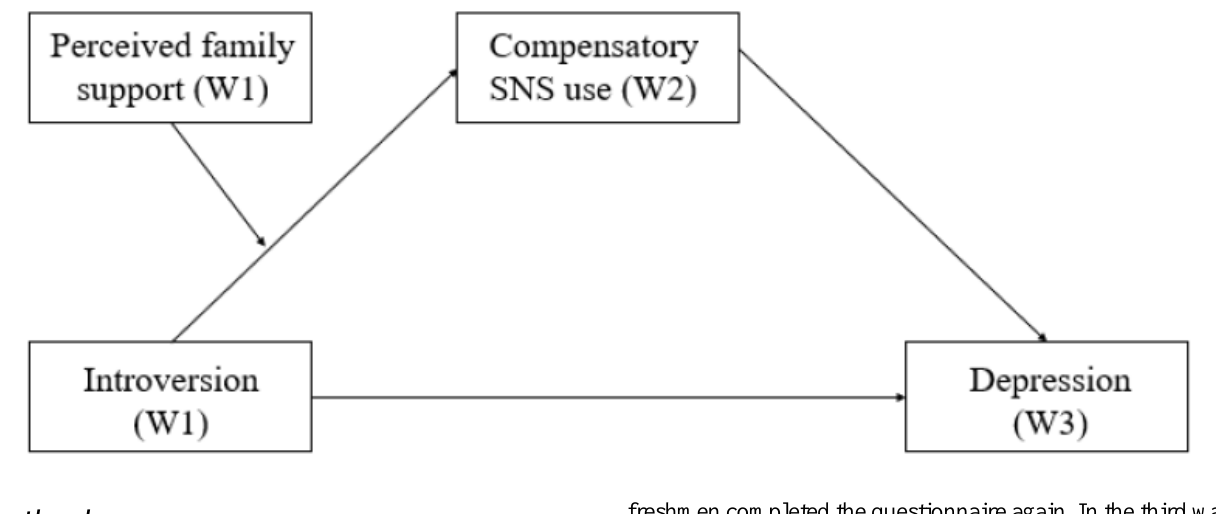
Figure 1. Proposed model of the relationship between introversion (W1) and Depression (W3), with compensatory use of SNSs (W2) as a mediator and family support (W1) as a moderator on this mediating